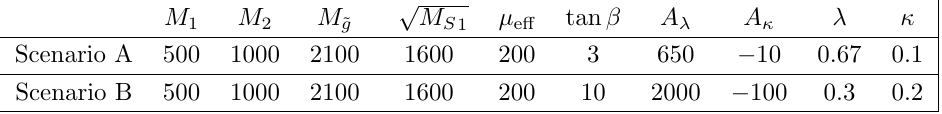
Table 2 . Two set of (cid:12)xed parameters, all being de(cid:12)ned at the scale 1 TeV, for the Z 3 -invariant NMSSM with NMFV. They are given in units of \GeV" except for tan (cid:12) , (cid:21) , and (cid:20)